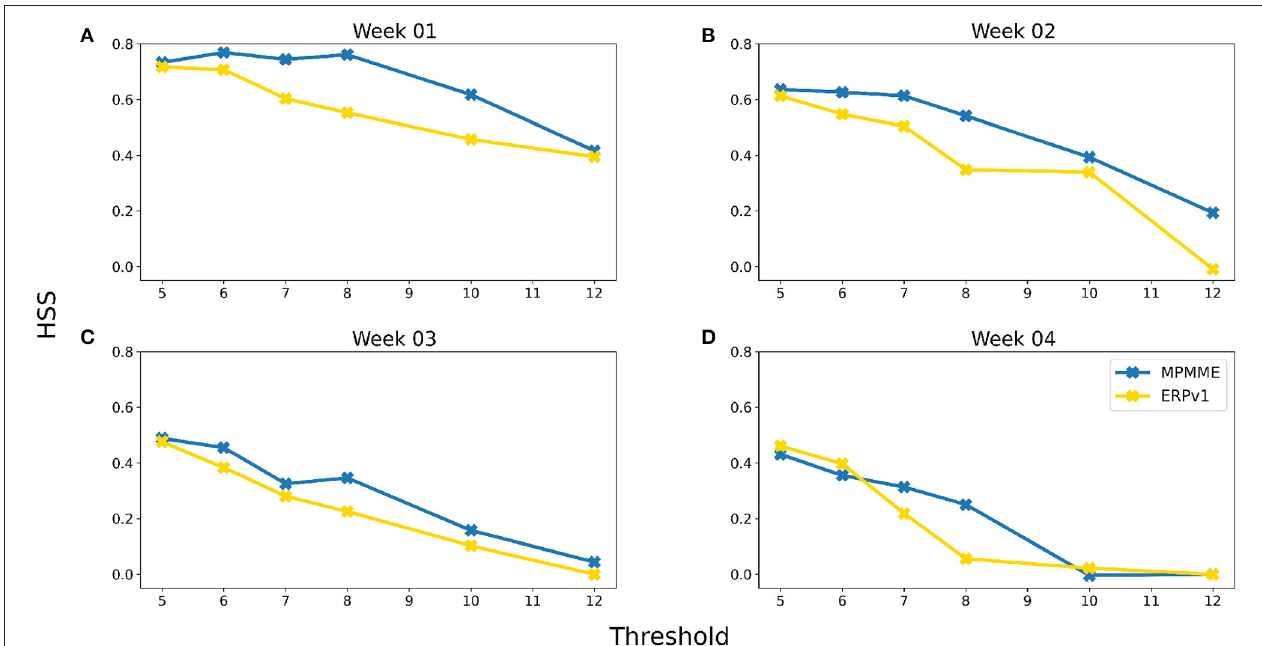
FIGURE 3 | Heidke Skill score at different thresholds of weekly mean rainfall over Monsoon Zone of India for (A) week 1, (B) week 2, (C) week 3, and (D) week 4 lead.